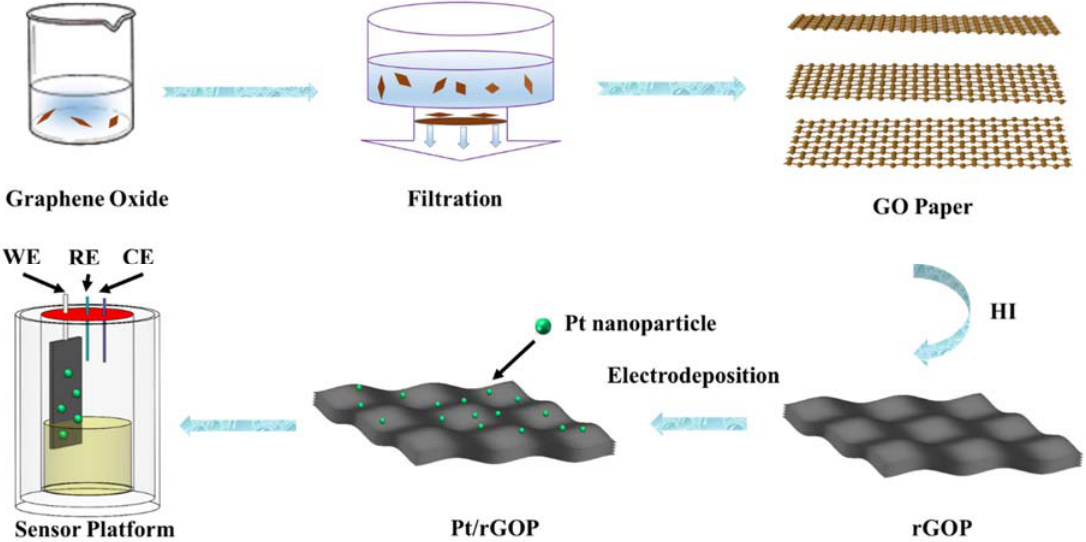
Figure 1. Illustrative fabrication process of the Pt/rGOP electrode for detection of hydrogen peroxide.